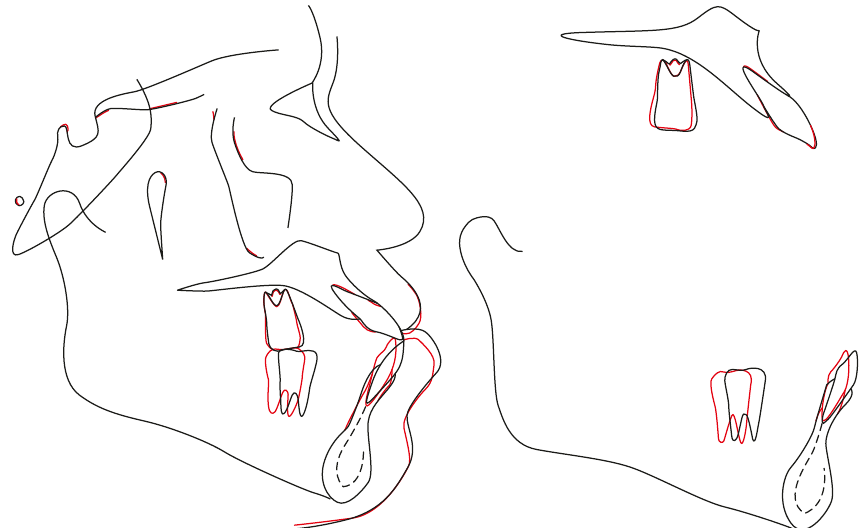
Figure 9: Superimpositions of pretreatment (black line) and posttreatment (red line) cephalometrc